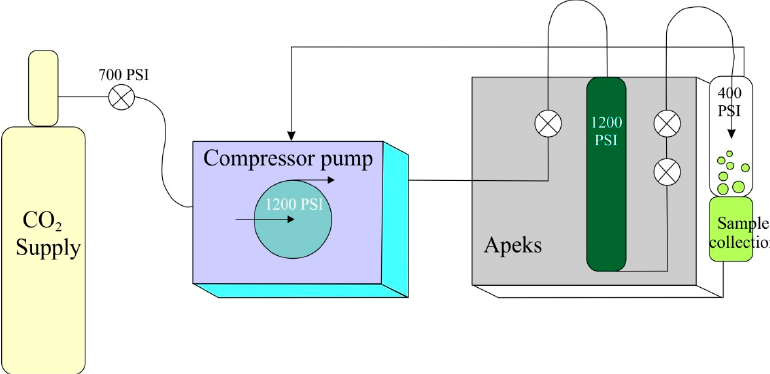
Figure 3. Supercritical fluid extraction (SFE) of essential oils (according Yousefi et al., 2019 [28]; modified).